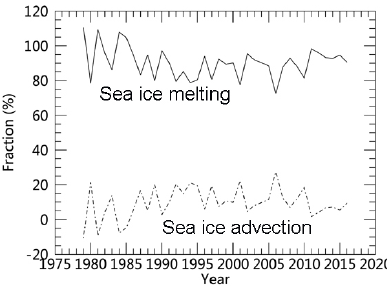
Figure 10. Fractions of sea ice area loss in the PA sector that are related to the sea ice melting and advection processes.